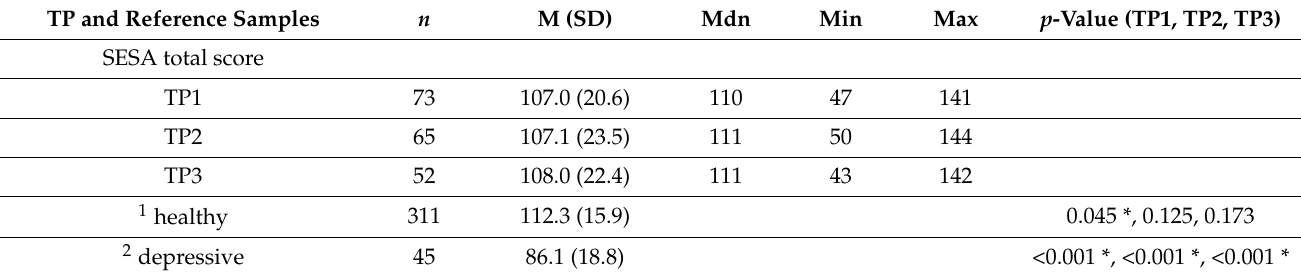
Table 12. Descriptive analysis and Wilcoxon signed-rank test of the SESA total score compared to the healthy and depressive reference samples. TP and Reference